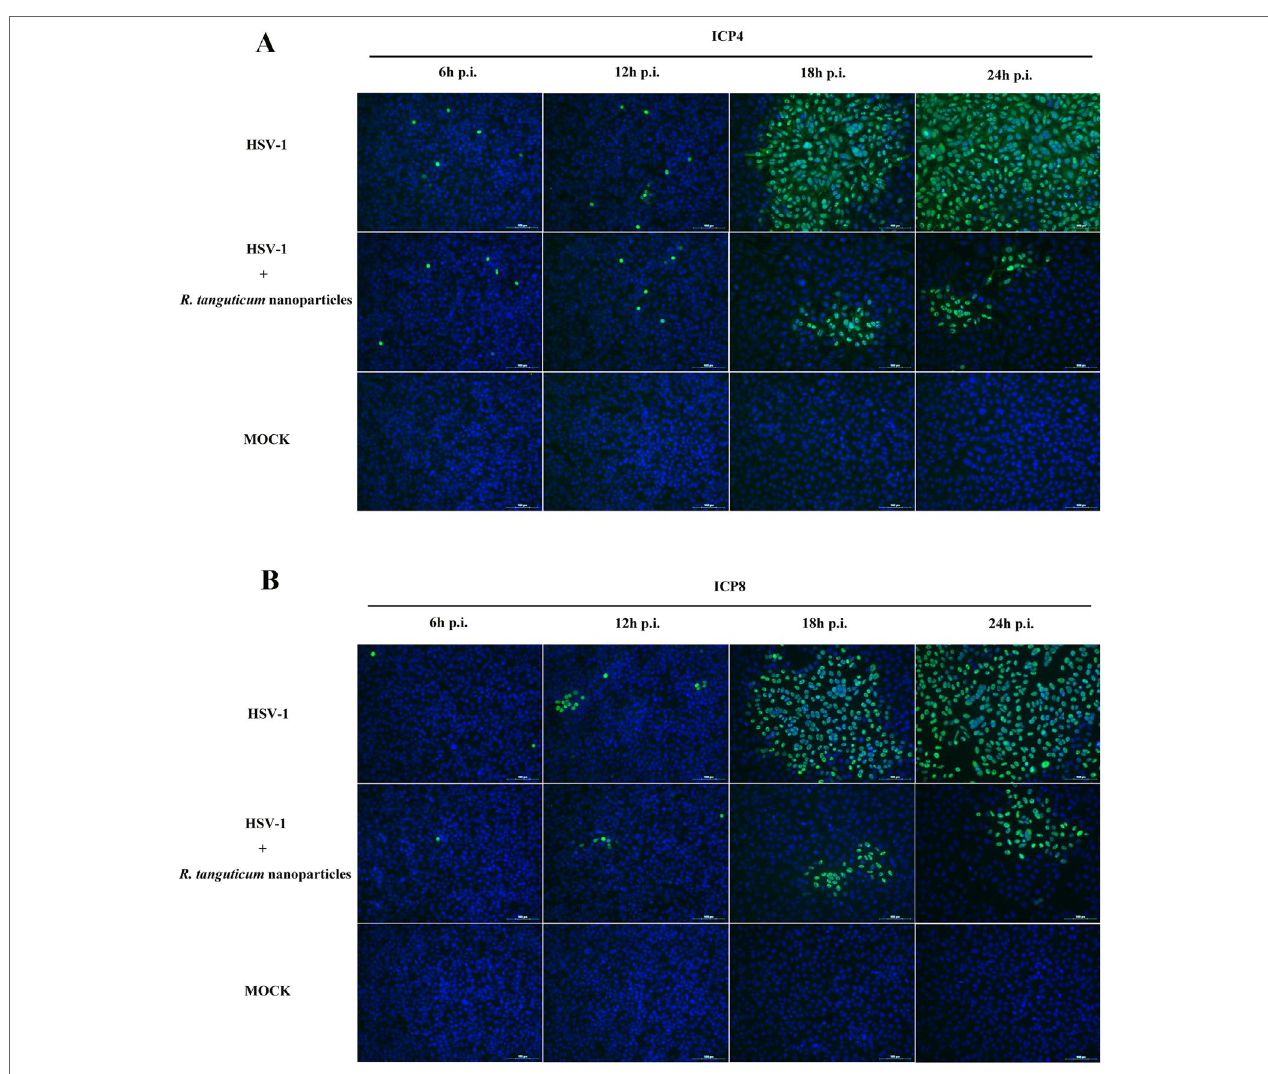
FIGURE 6 | Immunofluorescence assay of HSV-1 infected cells treated with R. tanguticum nanoparticles. (A–B) HEp-2 cells were infected with HSV-1 at an MOI of 0.01 and incubated with 350 µg/ml R. tanguticum nanoparticles. At 6, 12, 18, and 24 h.p.i., cells were fixed with paraformaldehyde and blocked in 1% BSA. After blocking, cells were stained of ICP4 and ICP8 . The nucleus was stained with DAPI and the green foci to indicate the presence of